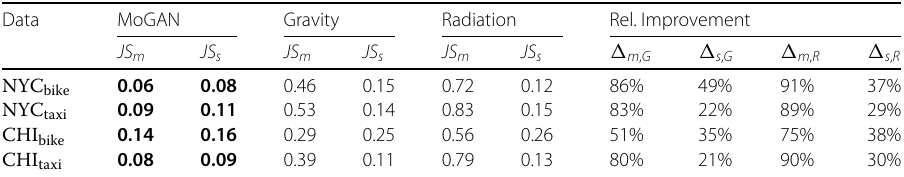
Table 2 JS divergences of the distributions of the CPC scores. For each model, we report the JS divergence between mixed set and test set (column JS m ) and the JS divergence between synthetic set and test set (column JS s ). The last four (cid:5) x , Z -like columns represent the improvement of MoGAN compared to the Gravity model on the mixed and the synthetic sets (columns (cid:5) m , G and (cid:5) s , G ) and the improvement of MoGAN compared to the Radiation model on the mixed and synthetic sets (columns (cid:5) m , R and (cid:5) s , R